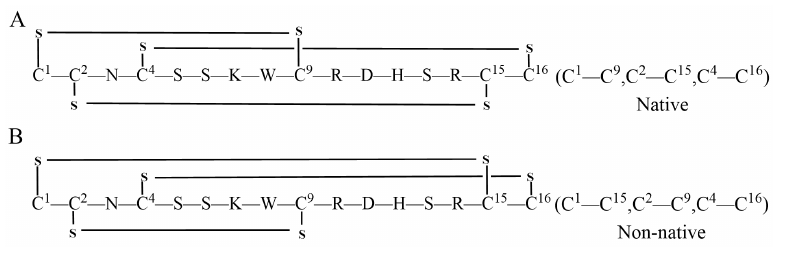
Figure 1. Two types of µ -KIIIA isomer, non-native isomer[C1 — C9, C2 — C15, C4 — C16] inhibits Nav1.2 ( A ) and Nav1.4 ( B ) with high potency.